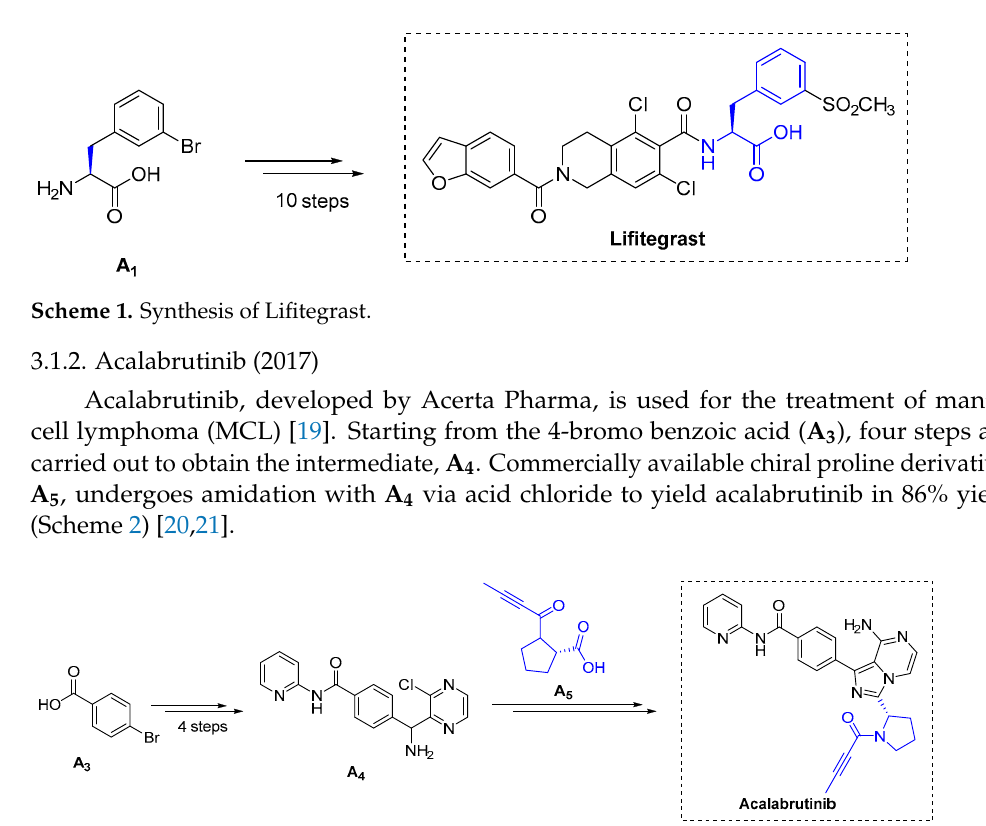
Figure 7. Classification of drugs on basis of their chiral induction.